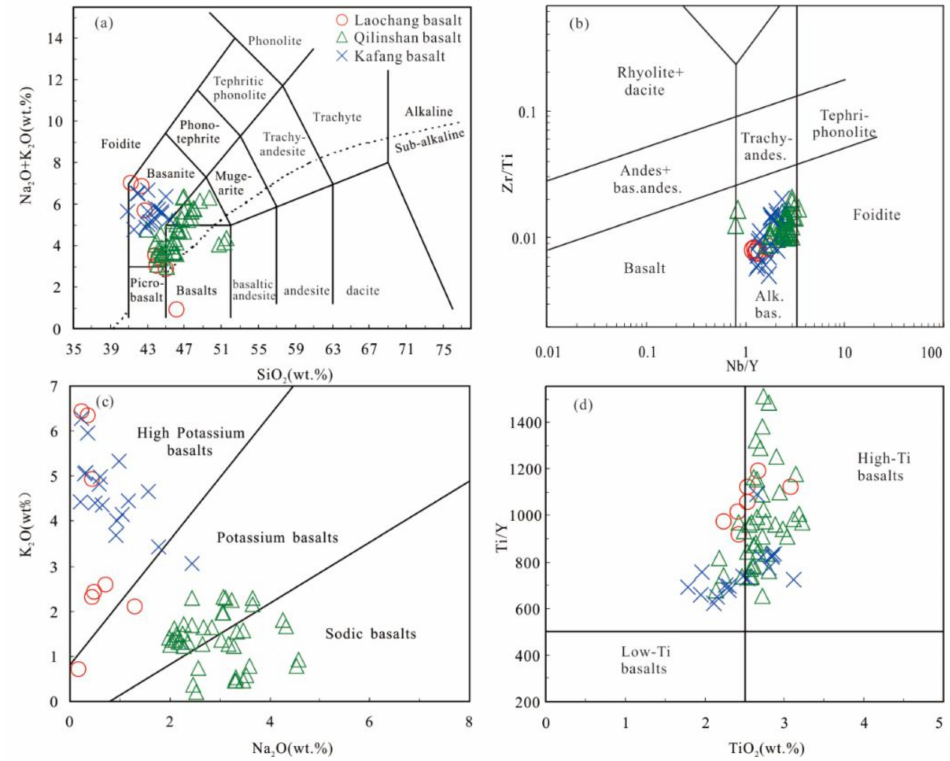
Figure 4. ( a ): SiO 2 vs. Na 2 O + K 2 O classification diagram; ( b ): Nb / Y vs. Zr / Ti diagram; ( c ): Na 2 O vs. K 2 O classification diagram; ( d ): TiO 2 vs. Ti / Y diagram. The data of Kafang from